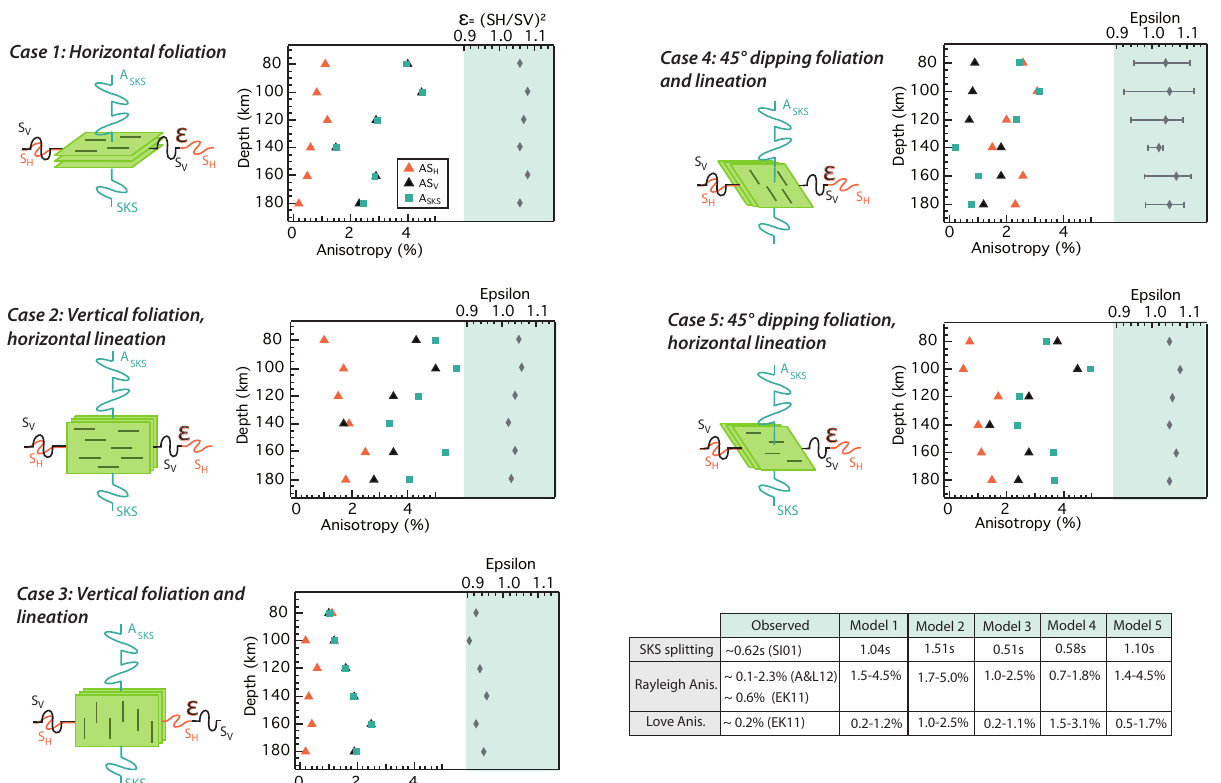
Fig. 7. Calculated surface wave polarization anisotropy ( ε = (S H /S V ) 2 ) , maximum azimuthal anisotropy of horizontally propagating S H and S V , and the maximum SKS anisotropy for the depth-averaged samples in five different “endmember” orientations of the foliation and the lineation: (1) horizontal foliation, (2) vertical foliation with a horizontal lineation, (3) vertical foliation and lineation, (4) 45 ◦ dipping foliation and lineation, and (5) 45 ◦ dipping foliation with a horizontal lineation. The table describes how well these different “endmember” models match SKS- and surface wave data (SI01: Silver et al., 2001; A&L12: Adam and Lebedev, 2012; EK11: Ekström,